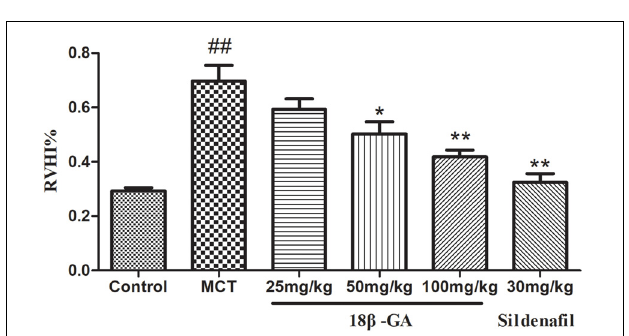
FIGURE 5 | Effect of 18 β -glycyrrhetinic acid on right ventricular hypertrophy index (RVHI). Data are expressed as mean ± SEM ( n = 10). ## p < 0.01 vs. control group, ∗ p < 0.05, ∗∗ p < 0.01 vs. MCT group. MCT, monocrotaline; 18 β -GA, 18 β -glycyrrhetinic acid; RVHI, right ventricular hypertrophy